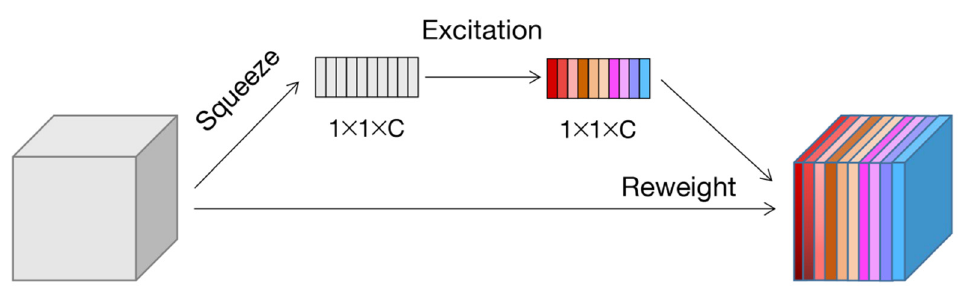
Figure 8. Squeeze and excitation structure.